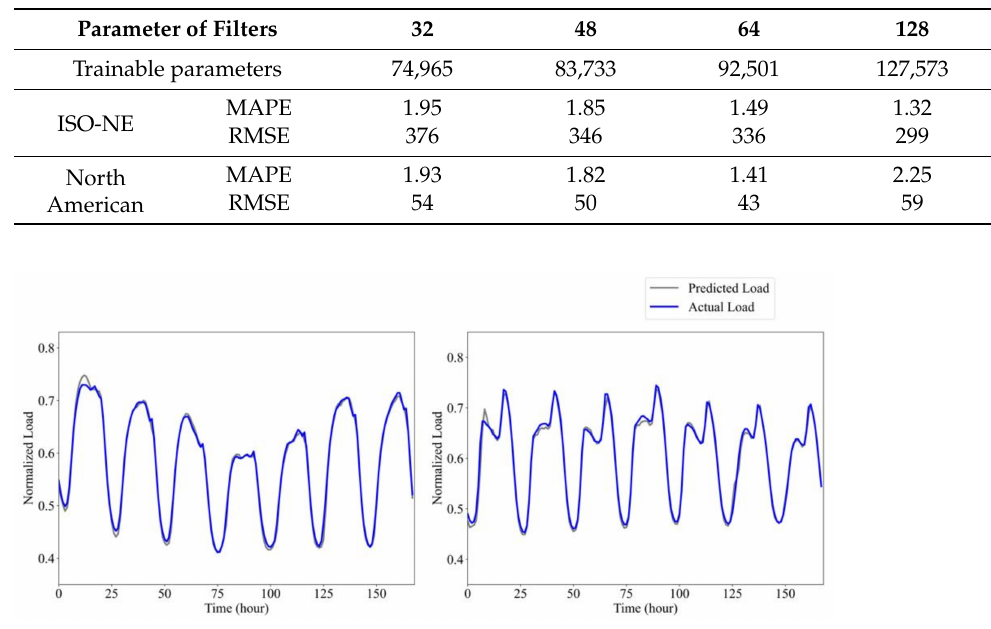
Table 1. MAPE, RMSE, and number of trainable parameters in two datasets corresponding to different parameter of filters.